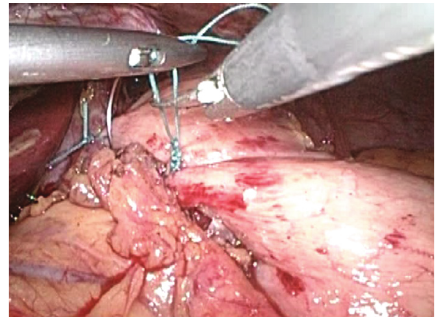
Figure 3: Creation of an anterior partial fundoplication after myot-